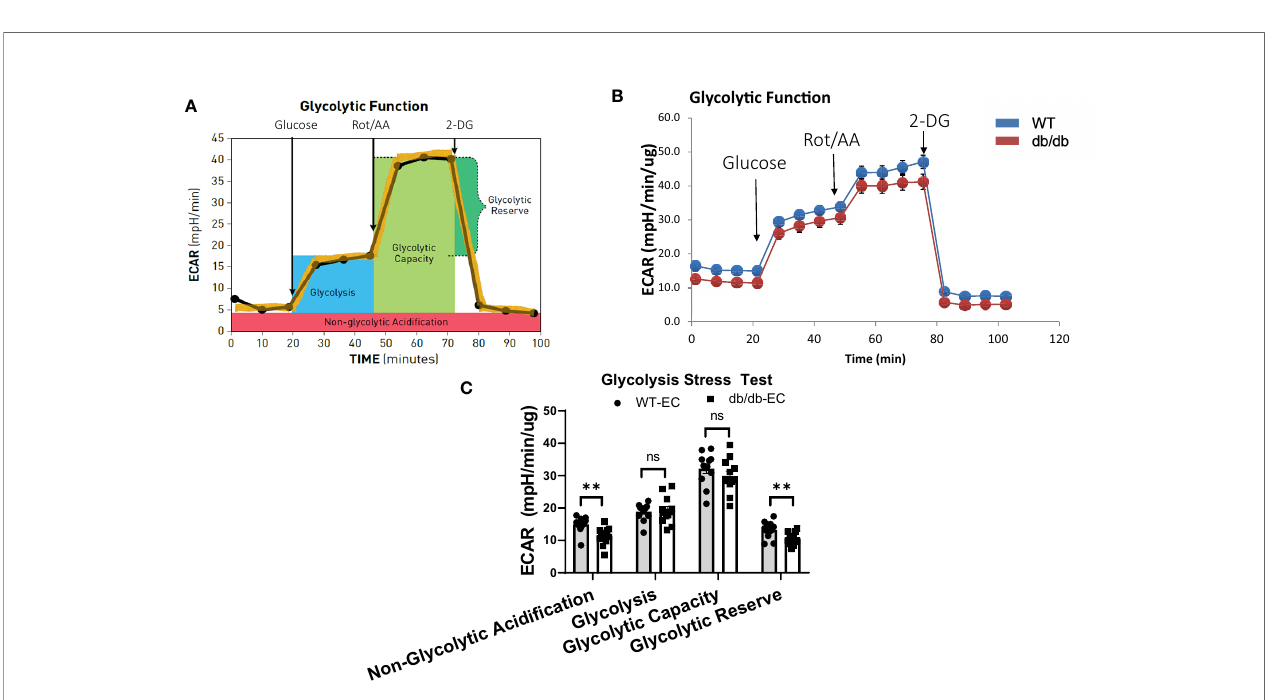
FIGURE 3 | Assessment of extracellular acidi fi cation rate (ECAR) in WT and diabetic CMECs. (A) Schematic representation of the protocol employed in data collection and calculations of glycolytic function. (B) Normalized ECAR data. (C) Parameters of glycolytic function calculated from the ECAR tracing in (B) . Results are normalized to total cellular protein and shown as mean ± SEM (n = 12), ns p > 0.05, **p <